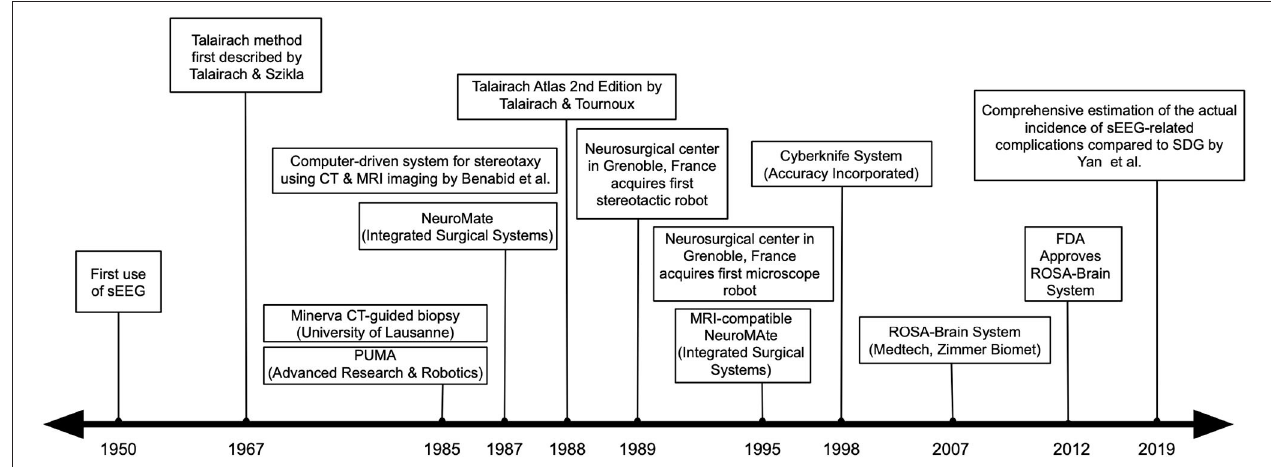
FIGURE 1 | A timeline of important events in the history of robotics in sEEG